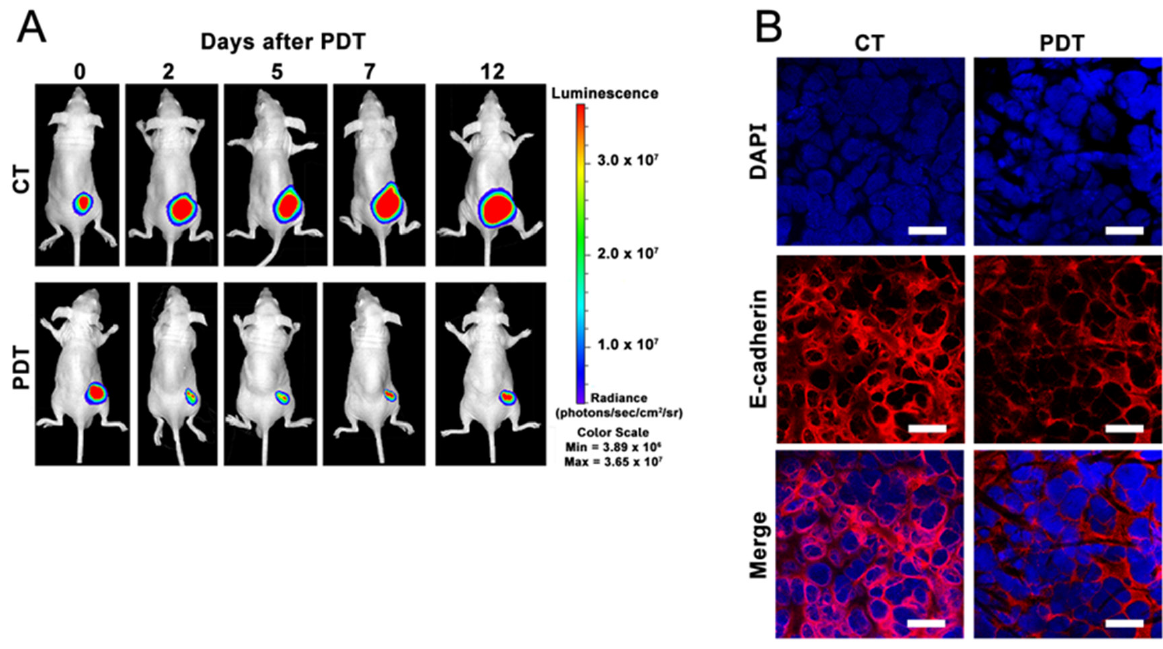
Figure 38 - ( A ) Representative bioluminescent images of mice at 2, 5, 7 and 12 days post PDT with Por-Gal cm 2 was performed 24 h after intraperitoneal injection with 5 µmol/kg of Por-Gal E-cadherin protein (red) in UM-UC-3luc+ tumors of control and treated group, with DAPI staining the nucleus (blue). Scale bars, 20 µm. Reproduced from Pereira et al. 2016b with permission of